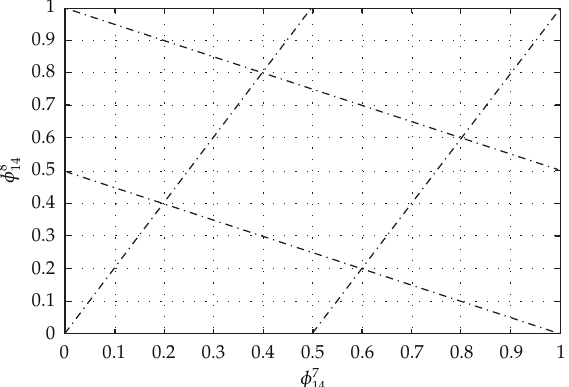
Figure 3: All points fall into Bernoulli-shift map after seven iterations under rule 14, where I (cid:7) 13.